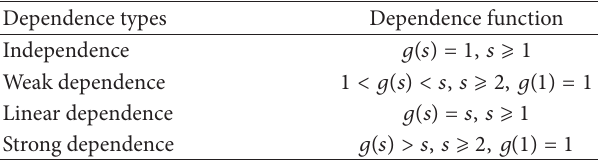
Table 3: Classification of redundant